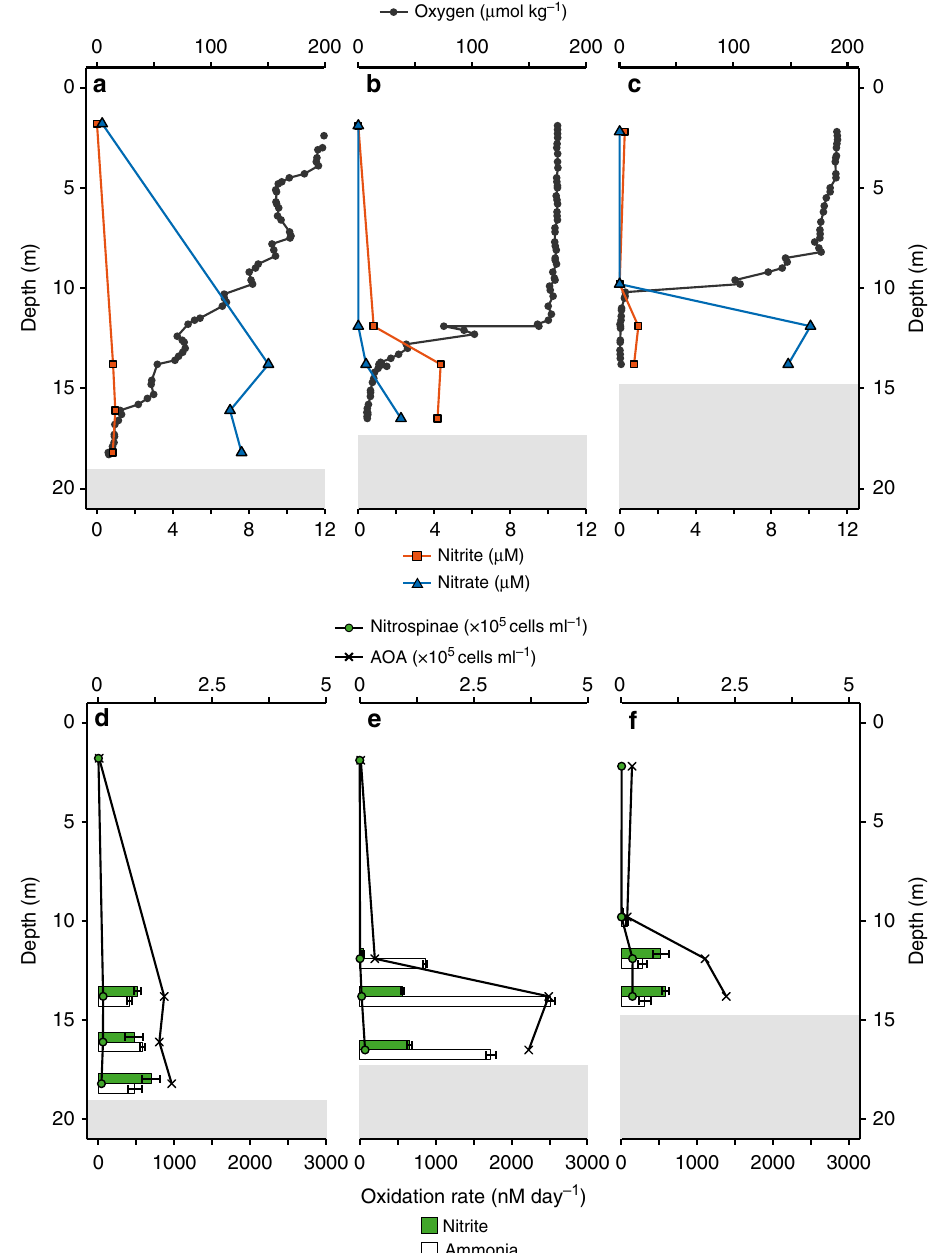
Fig. 1 Depth pro fi les of nutrient concentrations, nitrite and ammonia oxidation rates, and Nitrospinae and AOA cell counts 31 at stations in the Northern GoM. a – c In situ oxygen, nitrite and nitrate concentration pro fi les at Station 1 ( a ), Station 2 ( b ), and Station 3 ( c ). d – f Nitrite and ammonia oxidation rates and Nitrospinae and AOA CARD-FISH counts at Station 1 ( d ), Station 2 ( e ), and Station 3 ( f ). Nitrite and ammonia oxidation rates are depicted as green and white bars, respectively, and were calculated from slopes across all time points of triplicate incubations. Error bars represent standard error of the slope. Surface nitrite and nitrate concentrations ( a – c ) as well as CARD-FISH counts ( d – f ), were taken from the same station, the day before stable isotope labelling experiments were carried out. Shaded gray areas indicate sediment (max. water depth was 18.5m) (see also Supplementary Fig.